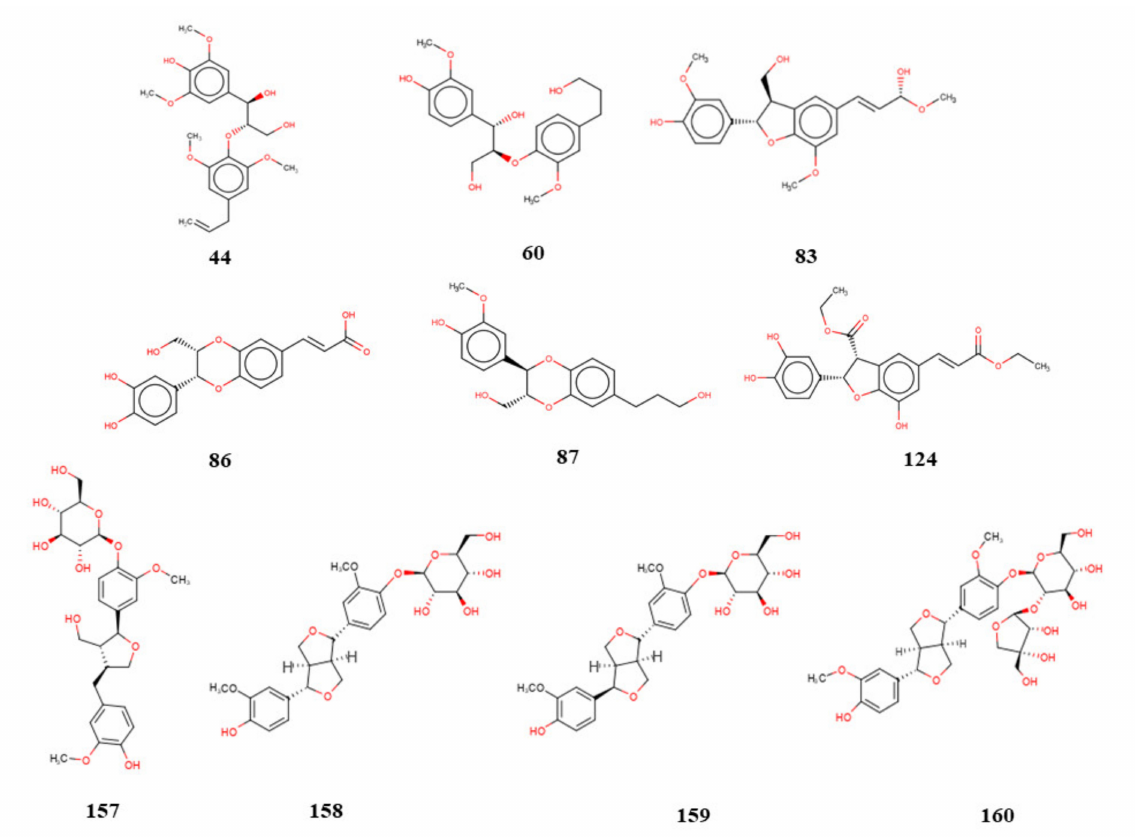
Figure 4. Common compounds that are considered to be potentially active against L. major and L. braziliensis , based on the random forest model, selected by the consensus analysis, combined with the fit values, and identified as